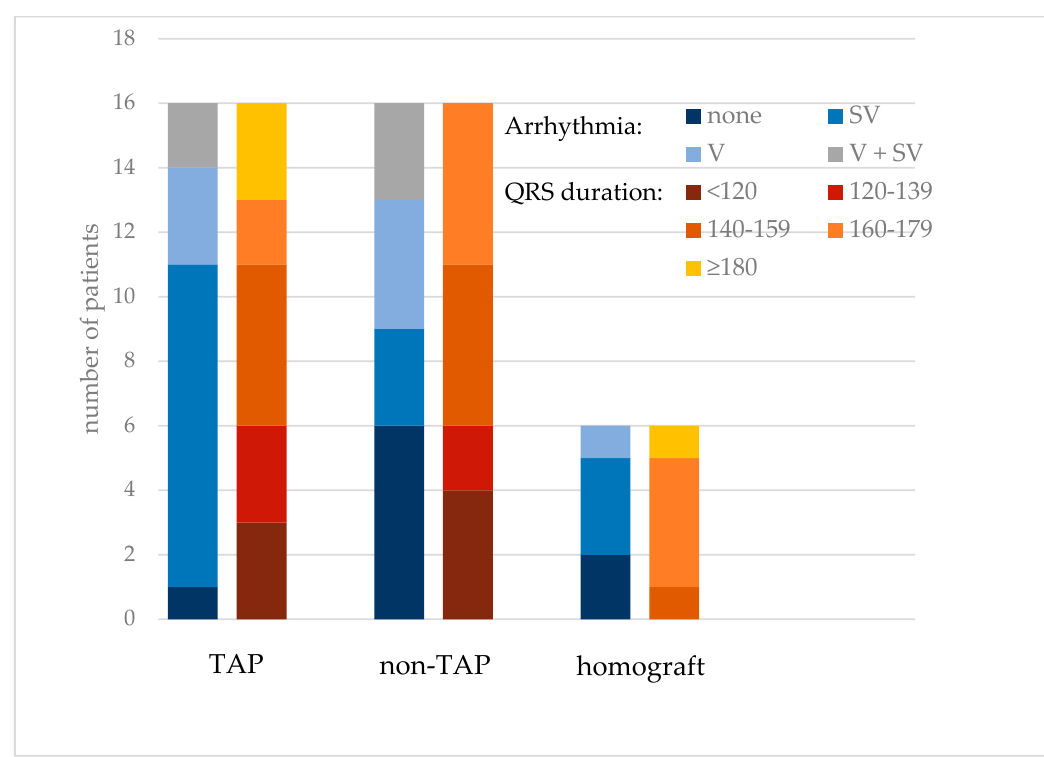
Figure 2. The presence of ventricular and supraventricular arrhythmia along with QRS duration in rTOF patients according to the type of RVOT reconstruction; non-TAP = reconstruction of the right ventricular outflow tract without transannular patch; TAP = transannular patch insertion; SV = supraventricular arrhythmia >0.1% of the recording; V = ventricular arrhythmia >0.1% of the recording; V + SV = both ventricular and supraventricular arrhythmia registered.